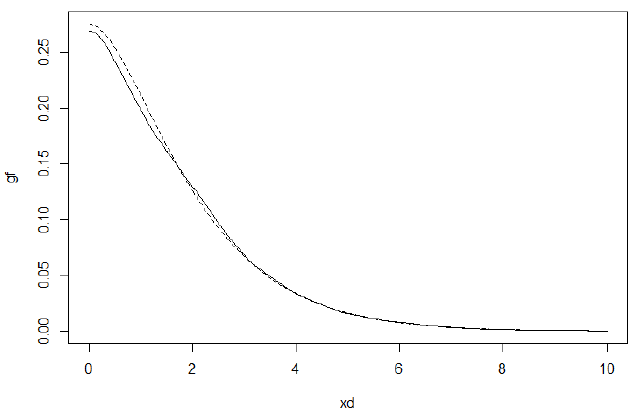
Figure 7. Estimator of g (solid line) and the model function (dashed line) for n = 1000.